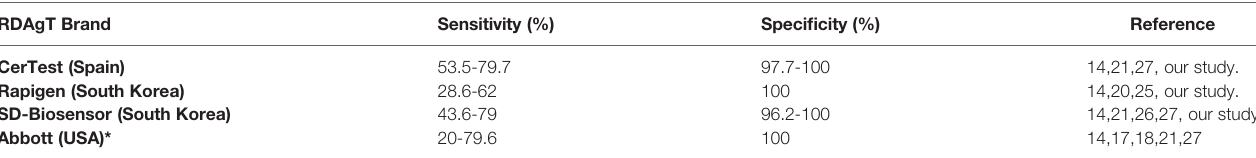
TABLE 6 | Comparative analysis of the clinical performance for several SARS-CoV-2 Rapid Diagnosis Antigen Test (RDAgTs) with evaluation studies published in peer review journals (* for Abbott, results from two different commercial RDAgTs are included). RDAgT